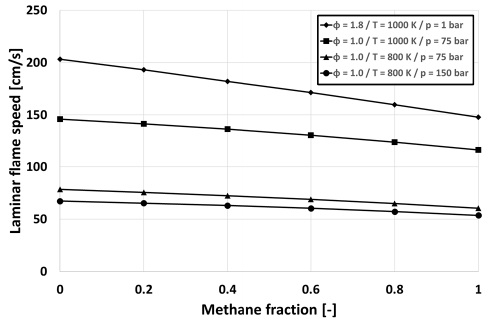
Figure 10. Laminar flame speed calculations for selected operating conditions. Calculations were performed with the full LLNL-v3 n-heptane mechanism. 0 on the x-axis indicates pure n-heptane, 1 indicates pure methane.